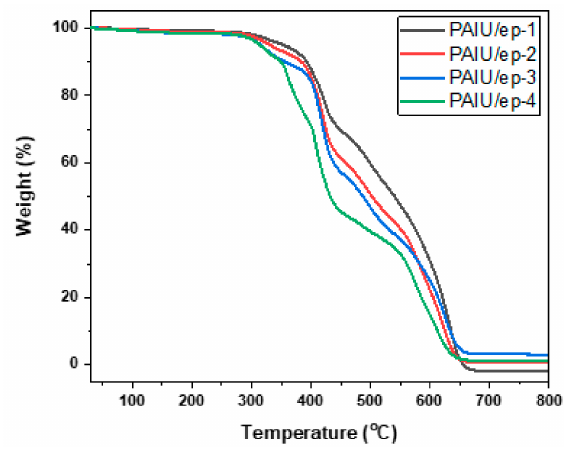
Figure 5. TGA thermographs of PAIU/epoxy